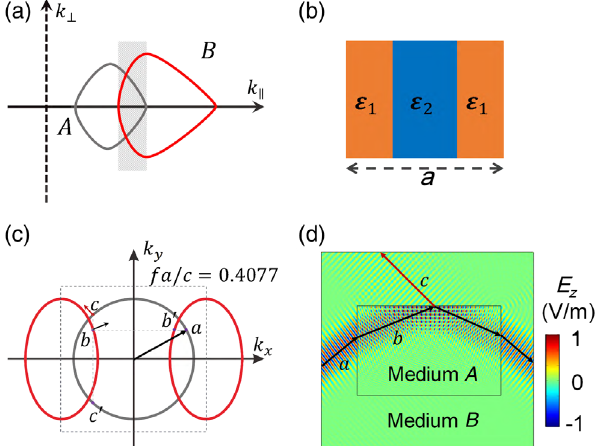
FIG. 7. Abnormal refraction due to the overlapping EFCs of medium A and B . (a) The schematic diagram of the EFCs of medium A and B when they have overlapping regions. (b) The structure of 1D PC with relative permittivity and filling ratio ε ¼ 2 ( ε ¼ 6 . 5 ) and 0.6 (0.4). (c) The EFCs of medium A (1D 1 2 PC) and B (free space) at the frequency fa=c ¼ 0 . 4077